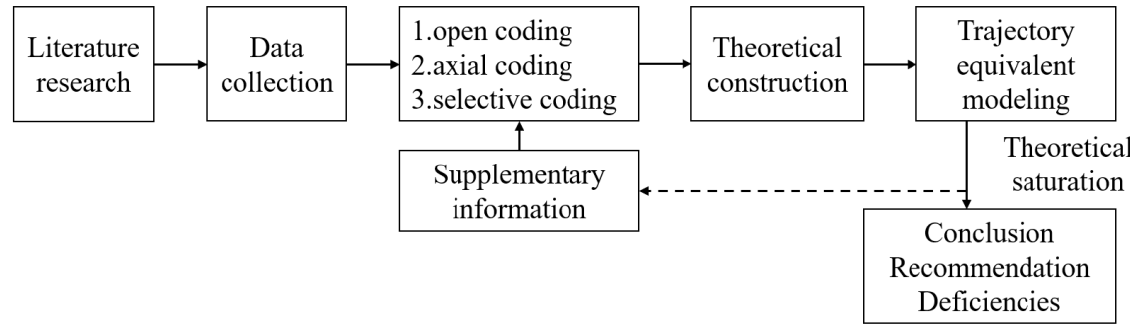
Figure 3. Research procedure of qualitative research.